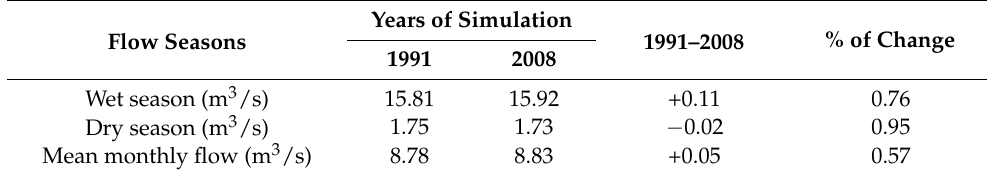
Table 6. Mean monthly simulated streamflow change due to the LULC change.